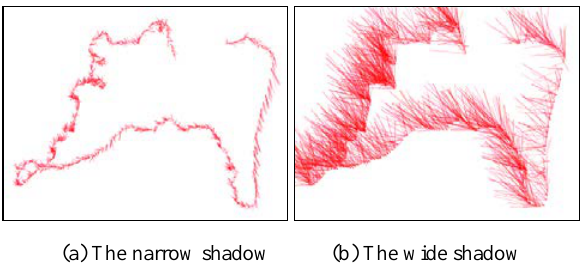
Figure 8. Rendering results with various length of shadow